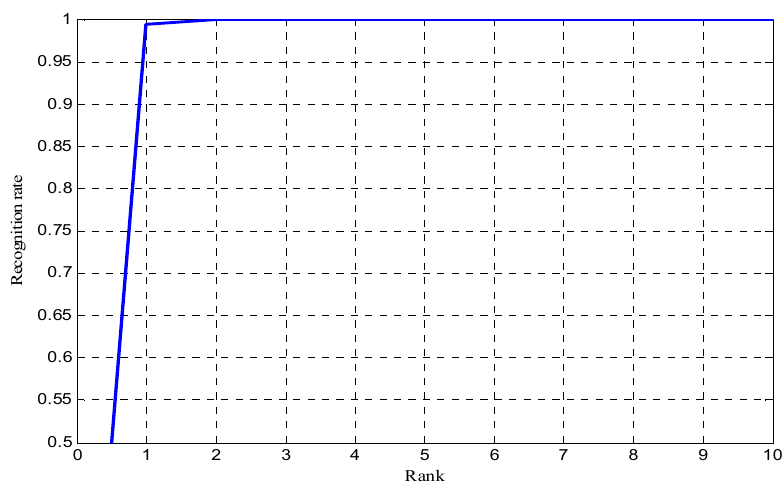
Figure 12. Cumulative match characteristic (CMC) curve for proposed face-iris multimodal system on CASIA-ORL database.